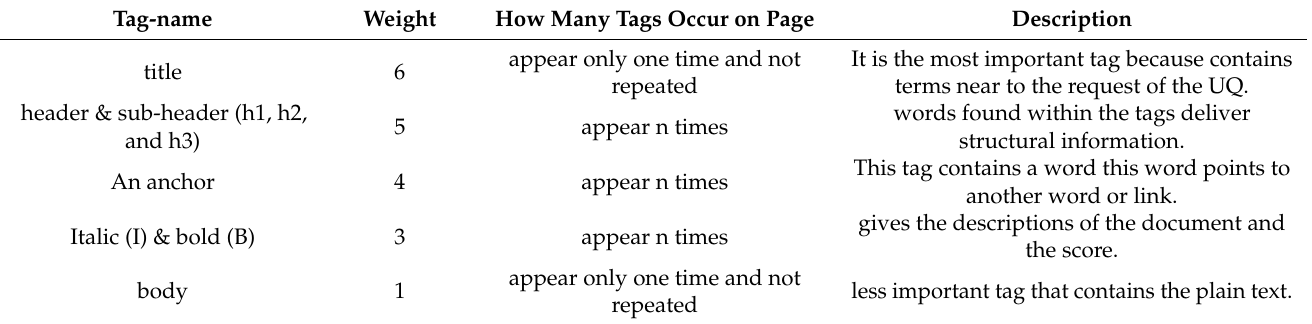
Table 6. Document-tags